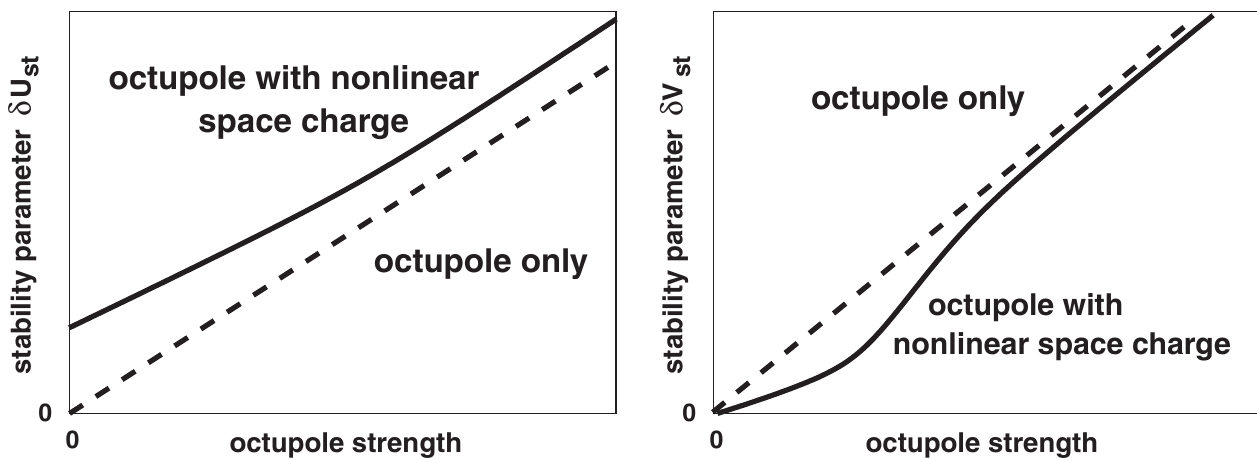
FIG. 3. Illustration for different regimes of stability provided by an octupole and nonlinear space charge: widths of the stability area along Im (cid:1) Z ? (cid:2) (left) and along Re (cid:1) Z ? (cid:2) (right) in a dependence from the strength of the octupole, with the tune spread due to space charge staying constant.